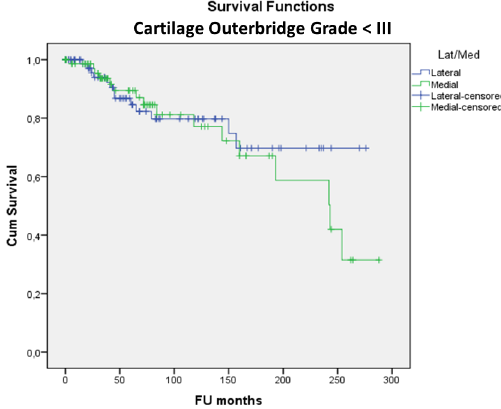
Fig 6. Kaplan-Meier cumulative survivorship of MAT in the cartilage Outerbridge grade < III group – lateral/medial: no statistically significant difference between lateral (blue line) and medial (green line) MAT (p =